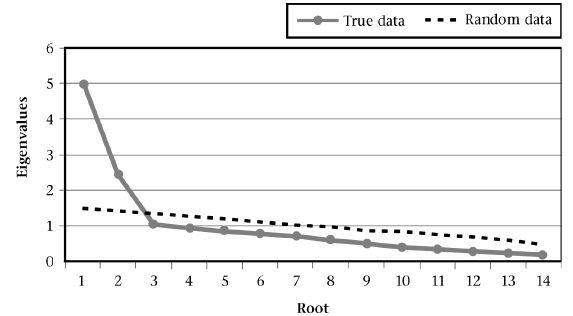
Figure 3: Scree-plot (White group)